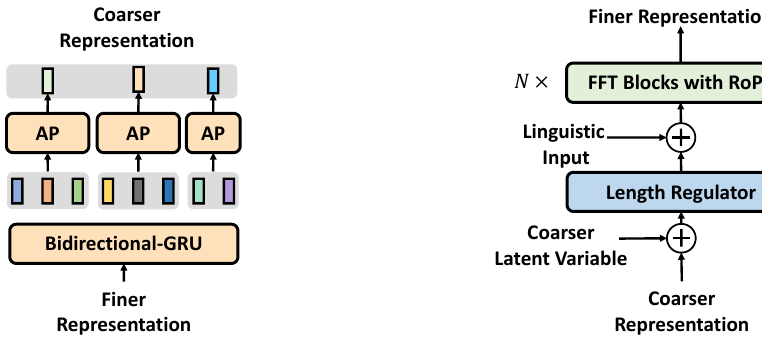
Figure 3. Components of fine-to-coarse and coarse-to-fine